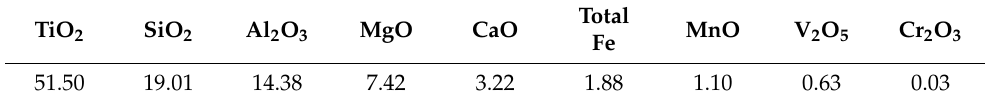
Table 1. The chemical composition of Ti-bearing electric furnace slag (TEFS) (wt%). TiO 2